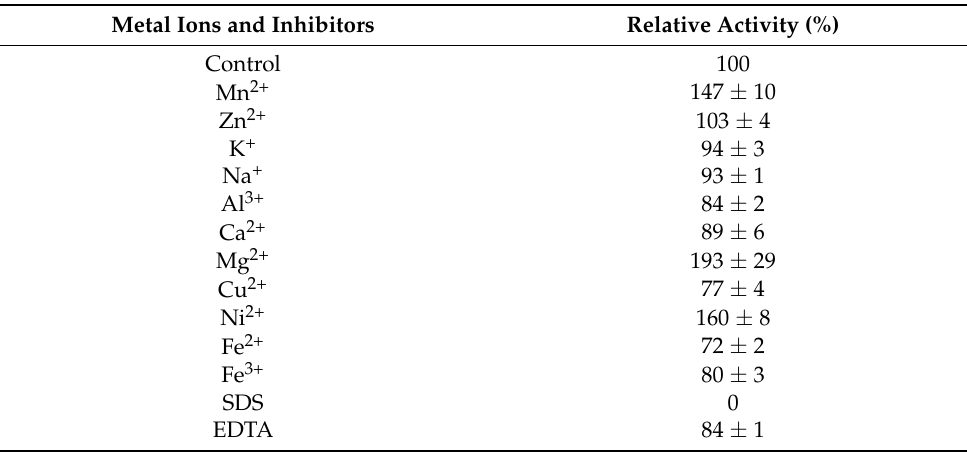
Table 2. Effects of metal ions and inhibitors on GmASNase activity.